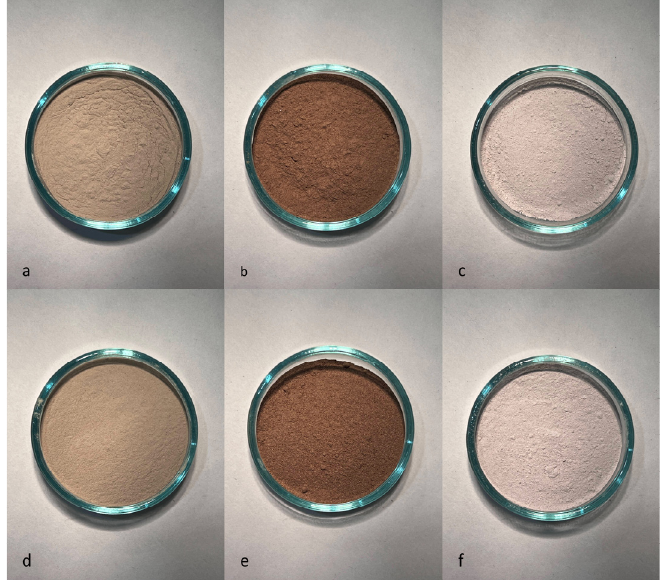
Figure 1. Ground 38 µ m ( a ) olive pomace, ( b ) walnut, and ( c ) mussel powders and ground 45 µ m ( d ) olive pomace, ( e ) walnut, and ( f ) mussel